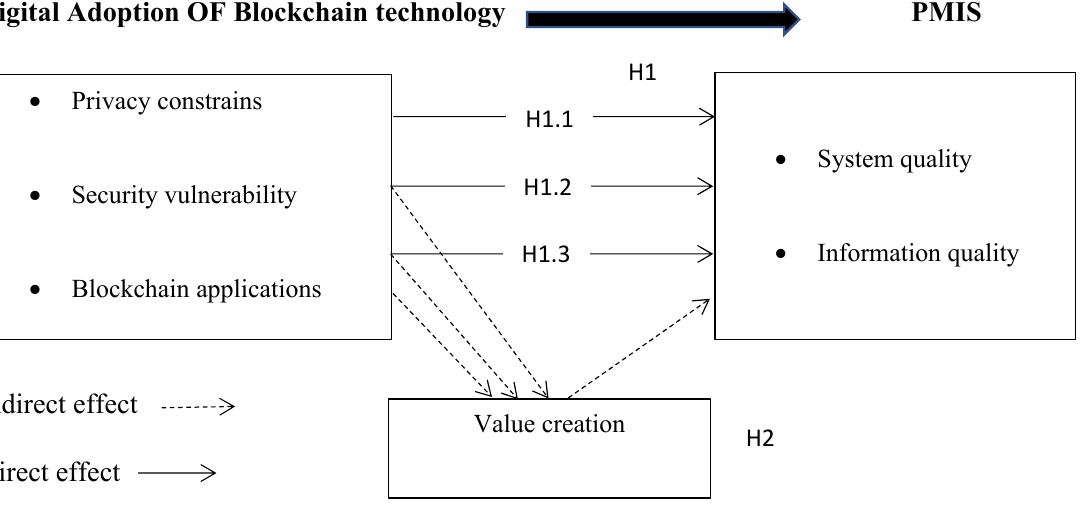
Fig. 1. Research Conceptual